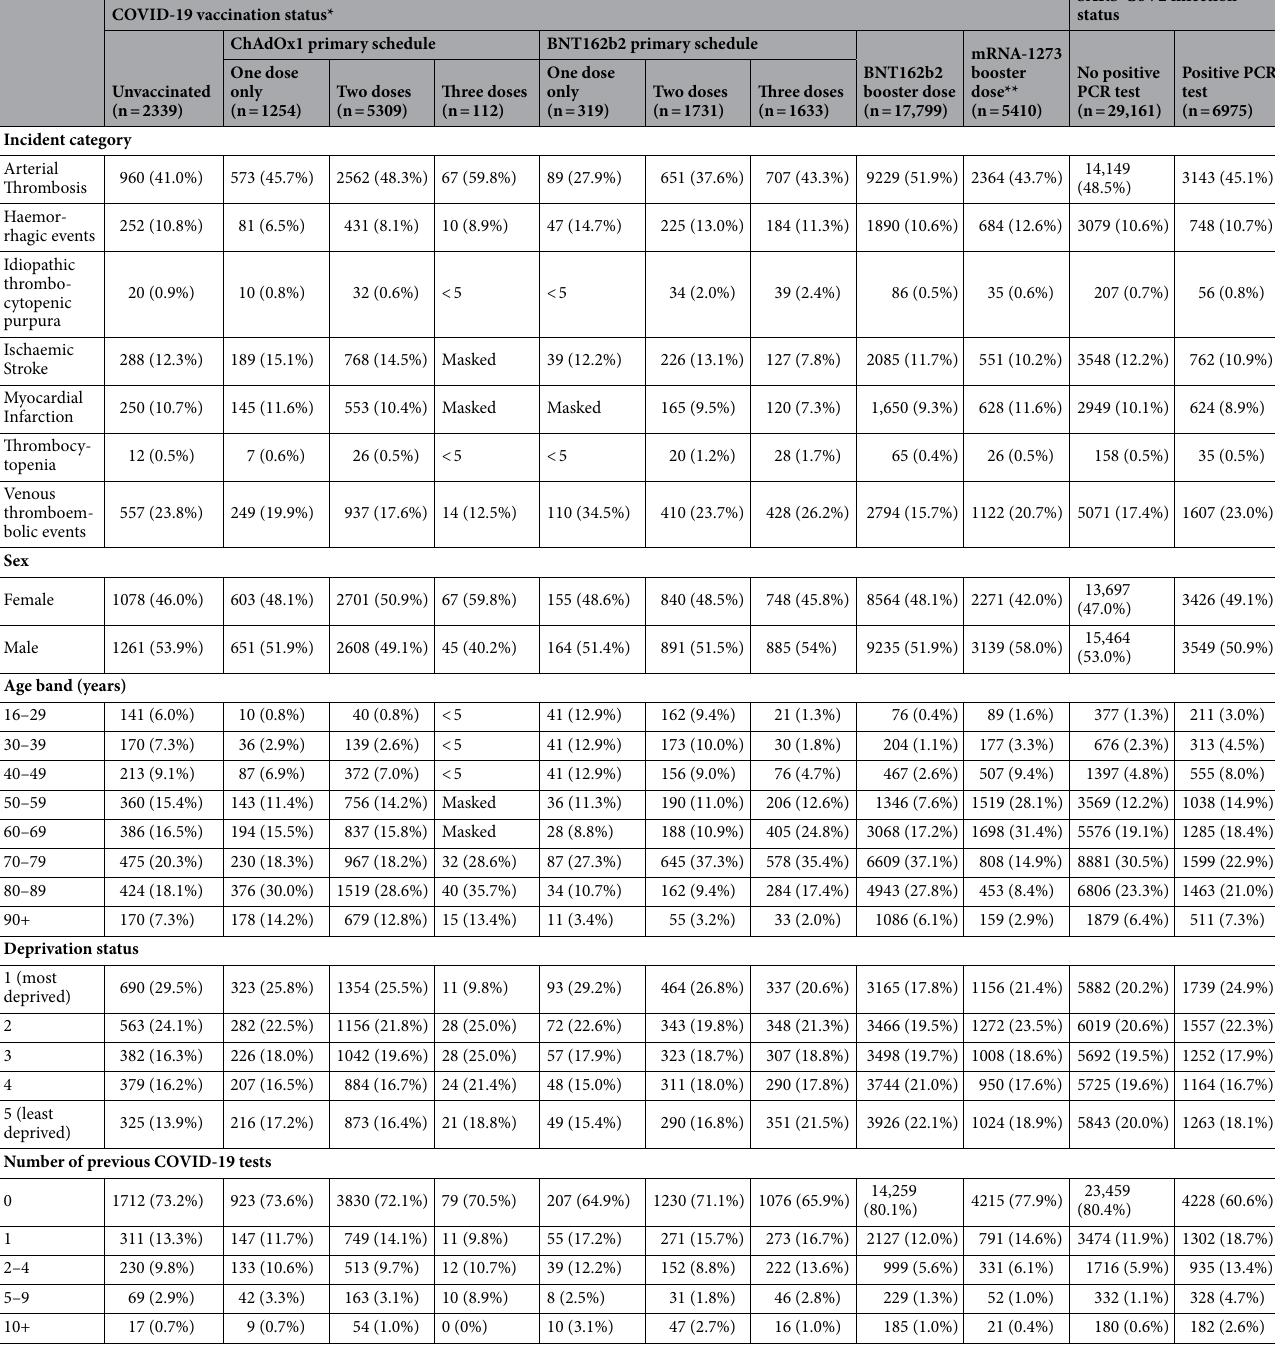
Table 1. Baseline characteristics of the study cohort (n = 36,136), stratified separately by vaccination status and PCR-confirmed SARS-CoV-2 infection status. *Not shown are the 290 that were either on their first, second or third dose of mRNA-1273 under the primary vaccination schedule. **Includes those who received half-dose of